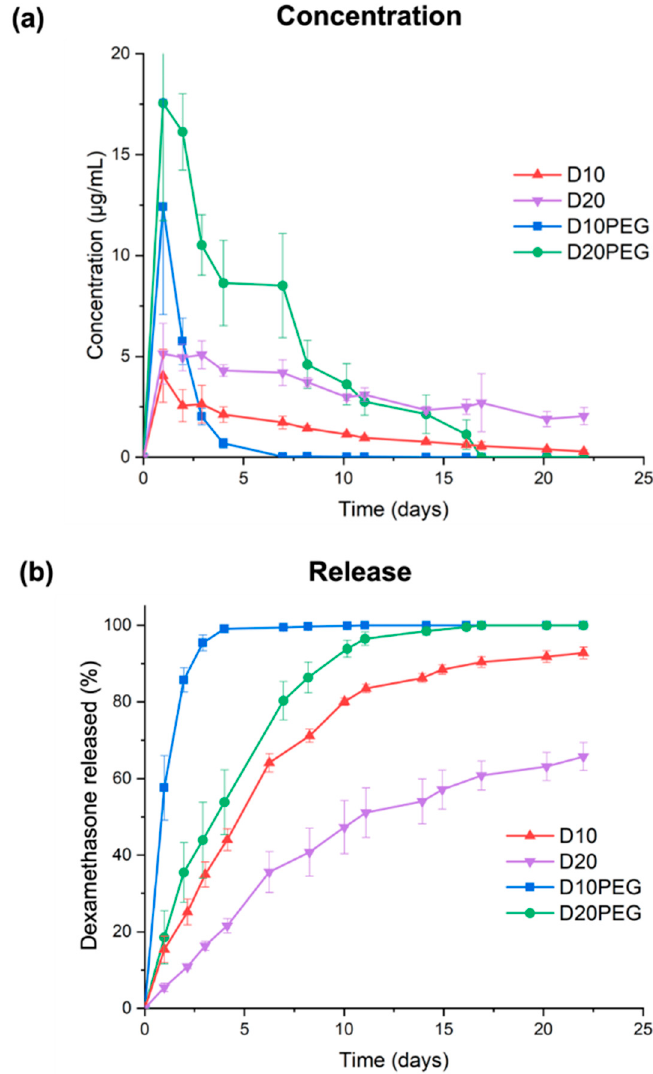
Figure 8. ( a ) Concentration and ( b ) cumulative release profile of dexamethasone of the DLP 3D printed punctal plugs in a rig model mimicking the subconjunctival space (~2.0 μ L/min, 37 °C). Data are shown as mean ± SD.